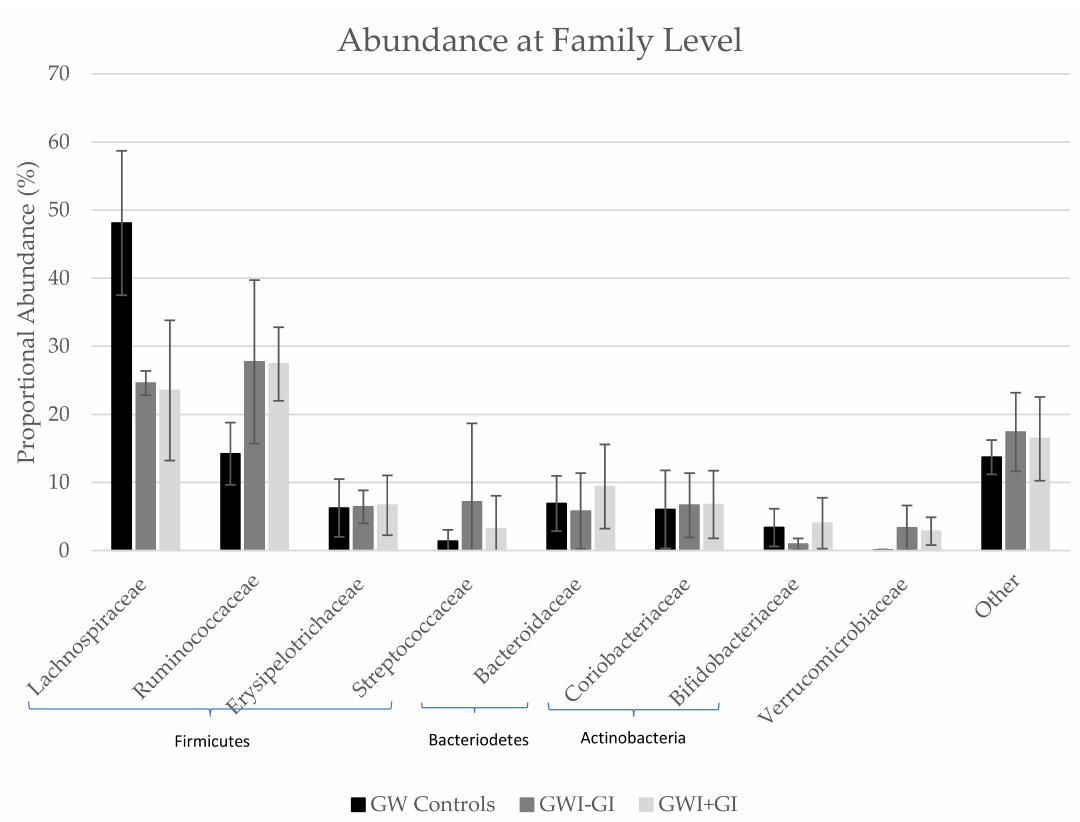
Figure 2. Proportional Abundance at the Phylum and Family Level by